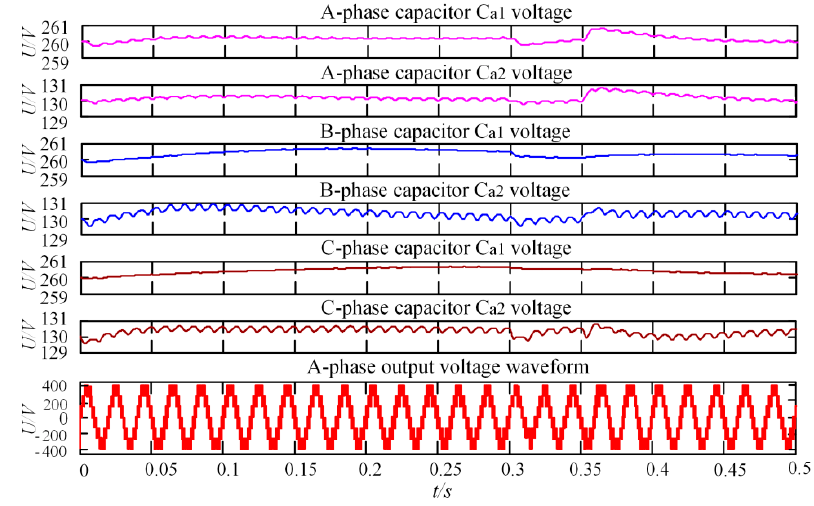
Figure 11. Each capacitor-voltage and the A-phase output voltage Figure 11 . Each capacitor-voltage and the A-phase output voltage waveform. Figure 11 . Each capacitor-voltage and the A-phase output voltage waveform.